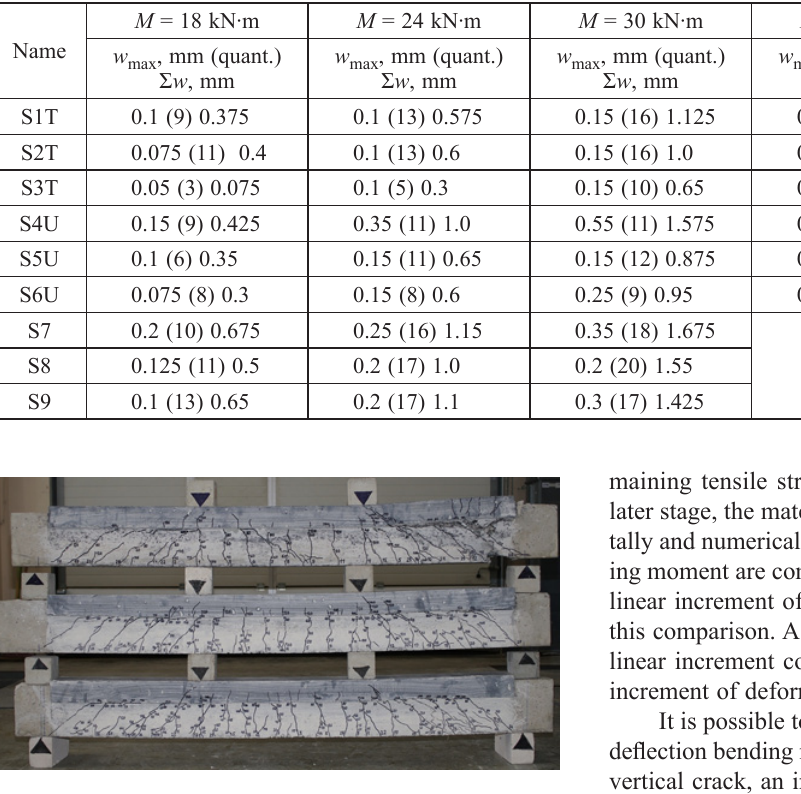
Fig. 11. Marked cracks on the S1T, S2T, and S3T beams (from the bottom)